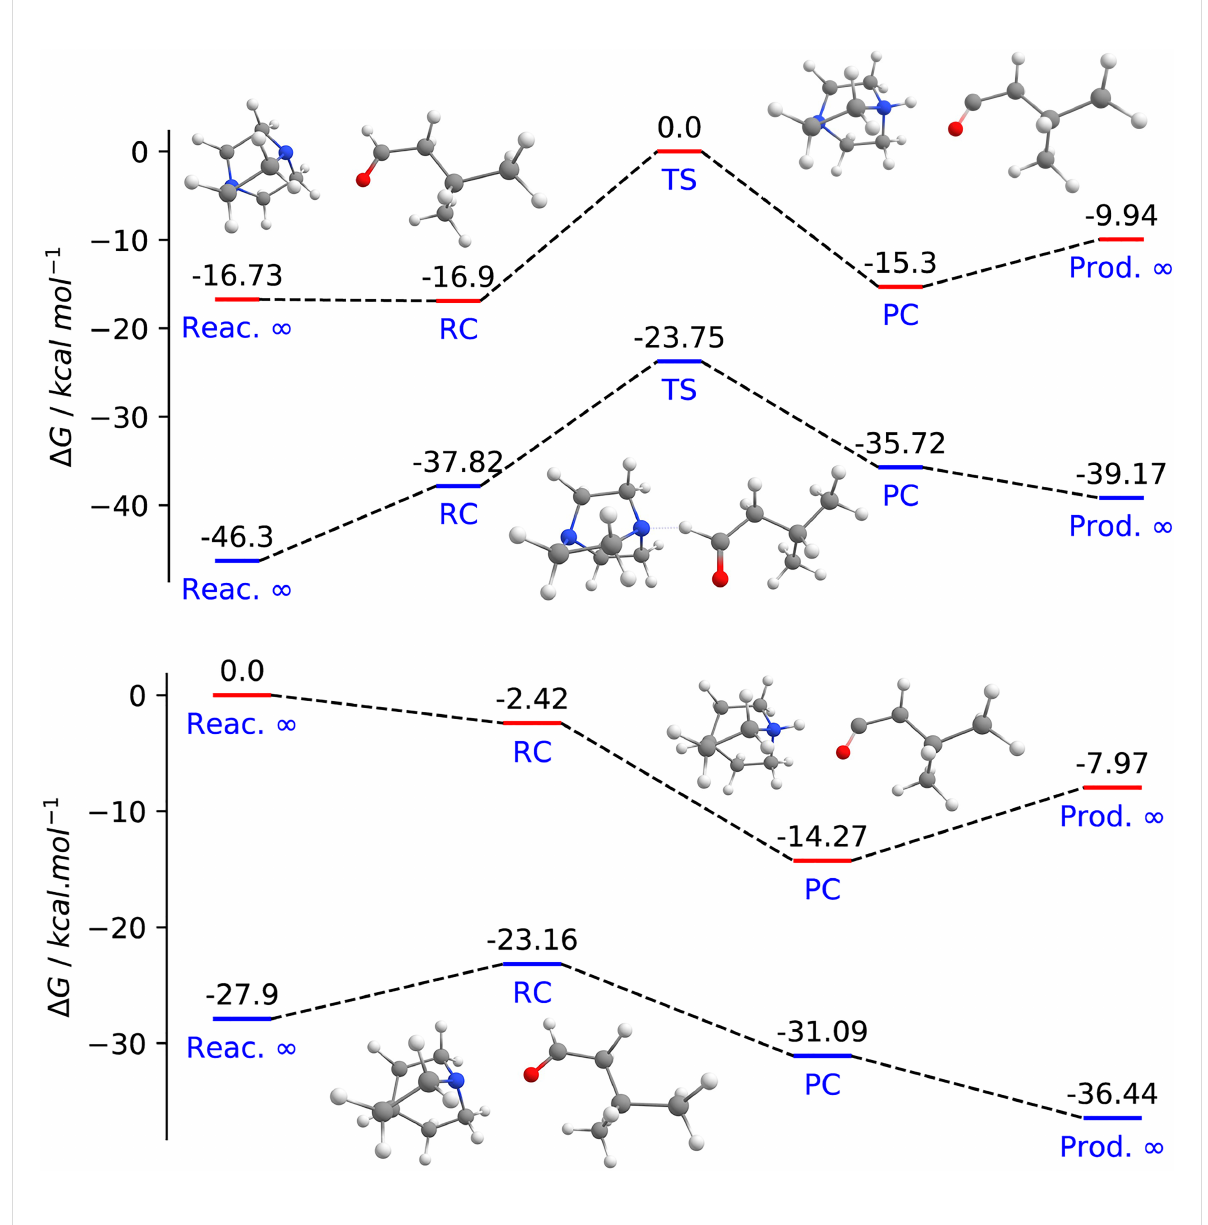
Figure 3: Free energy profile for the HAT step reactions between isovaleraldehyde with (top) DABCO and (bottom) quinuclidine radical cations. The red lines are for the gas phase results while the blue lines are for the PCM single points from the gas phase optimized geometry. RC – reactants com- plex; PC – product complexes. On both graphs the structure shown on the left represents the RC, on the right, PC and the top centre structure is for the TS between DABCO and the aldehyde.